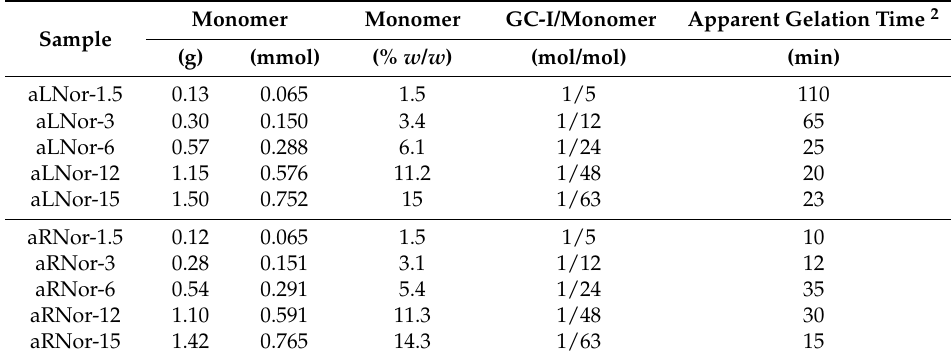
Table 4. Polymerization reactions of dendritic monomers aL-9-NBE and aR-9-NBE 1 .